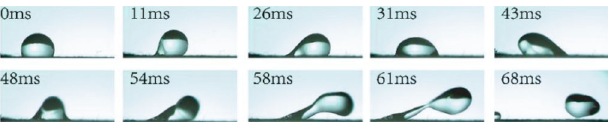
Figure 18: The movement of 8 μ L droplet on GDL surface under the interaction of horizontal vibration and air fl